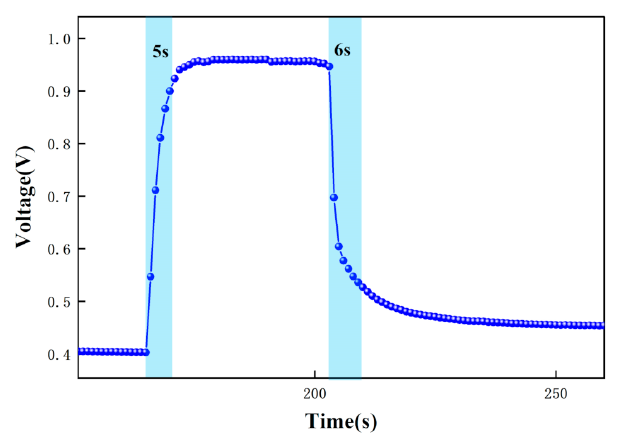
Figure 21. Response recovery time for testing at 10 ppm acetone.